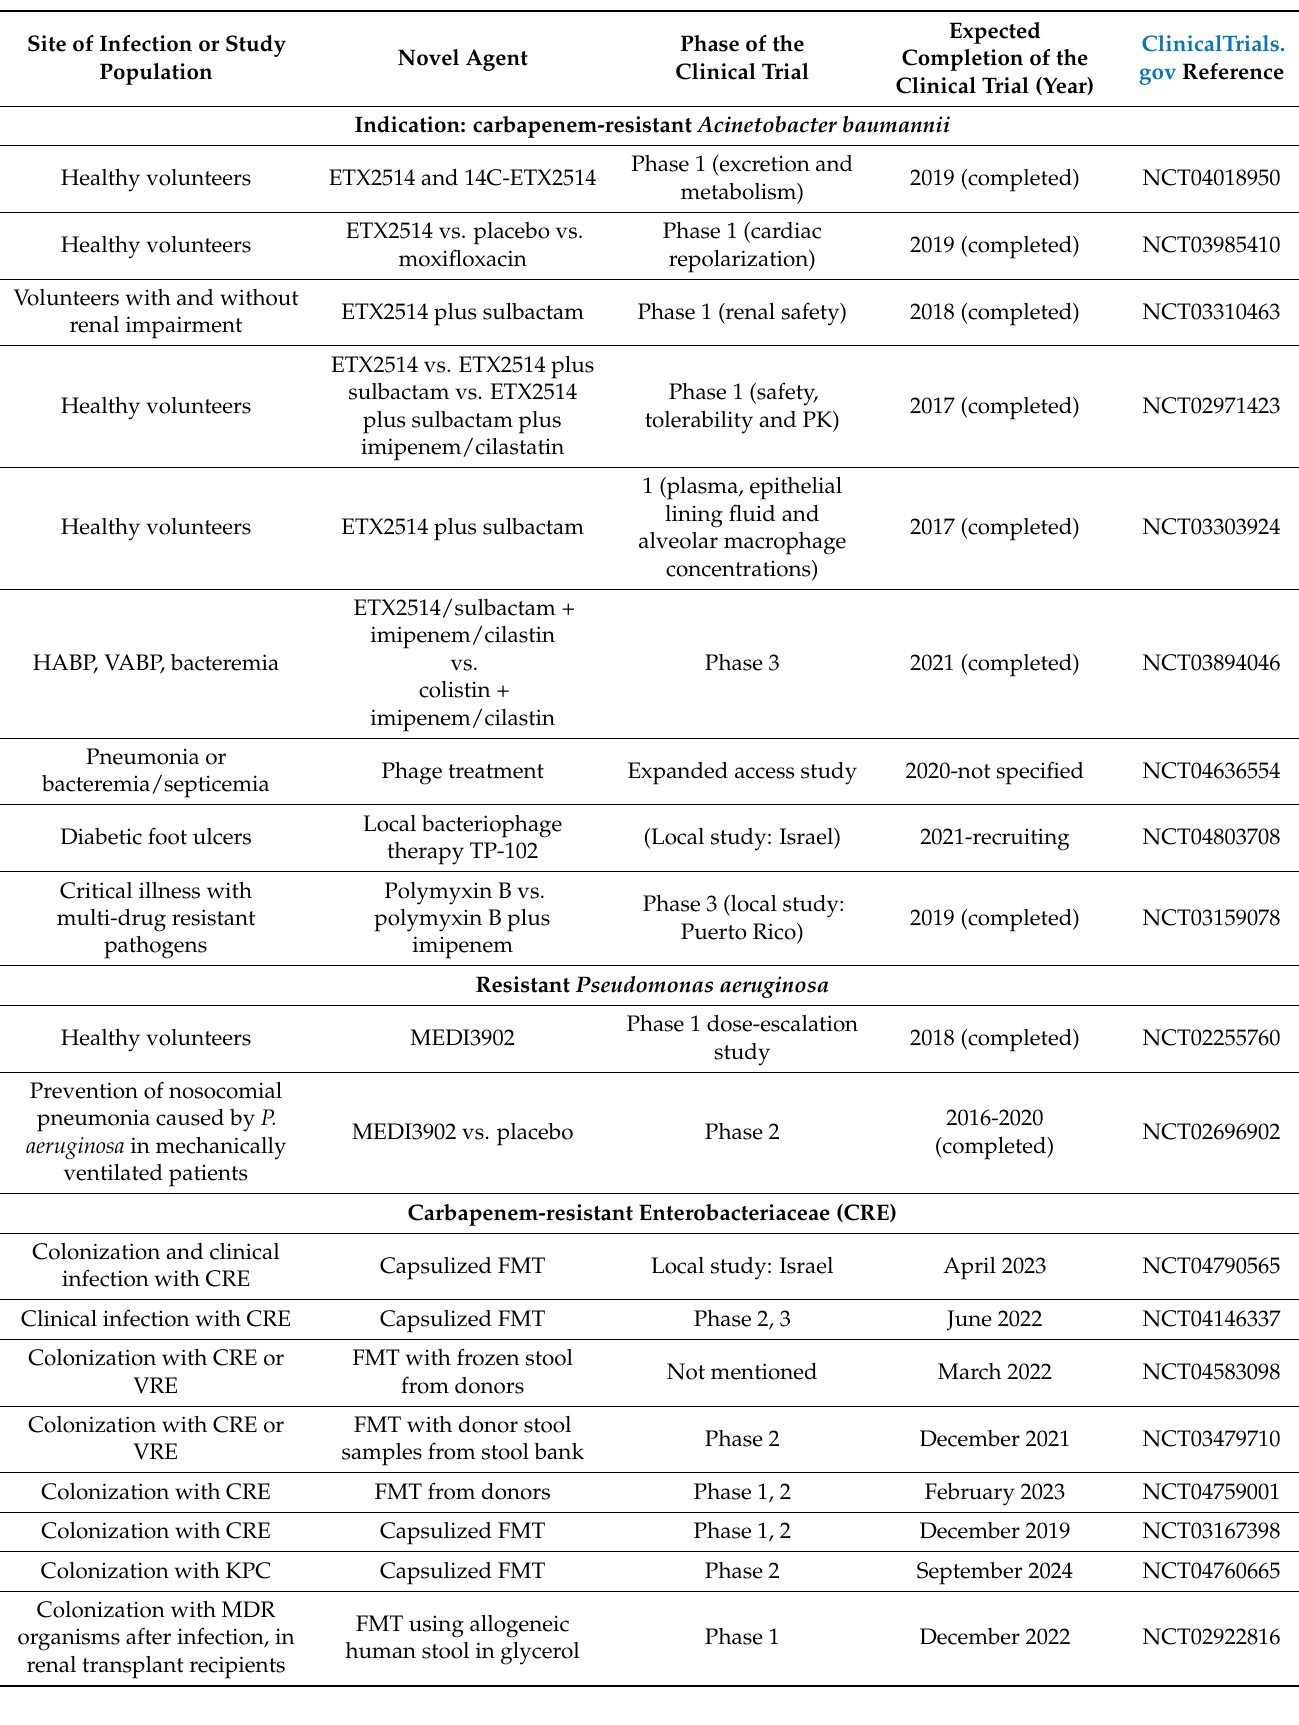
Table 1. Novel antimicrobials currently or recently evaluated in clinical